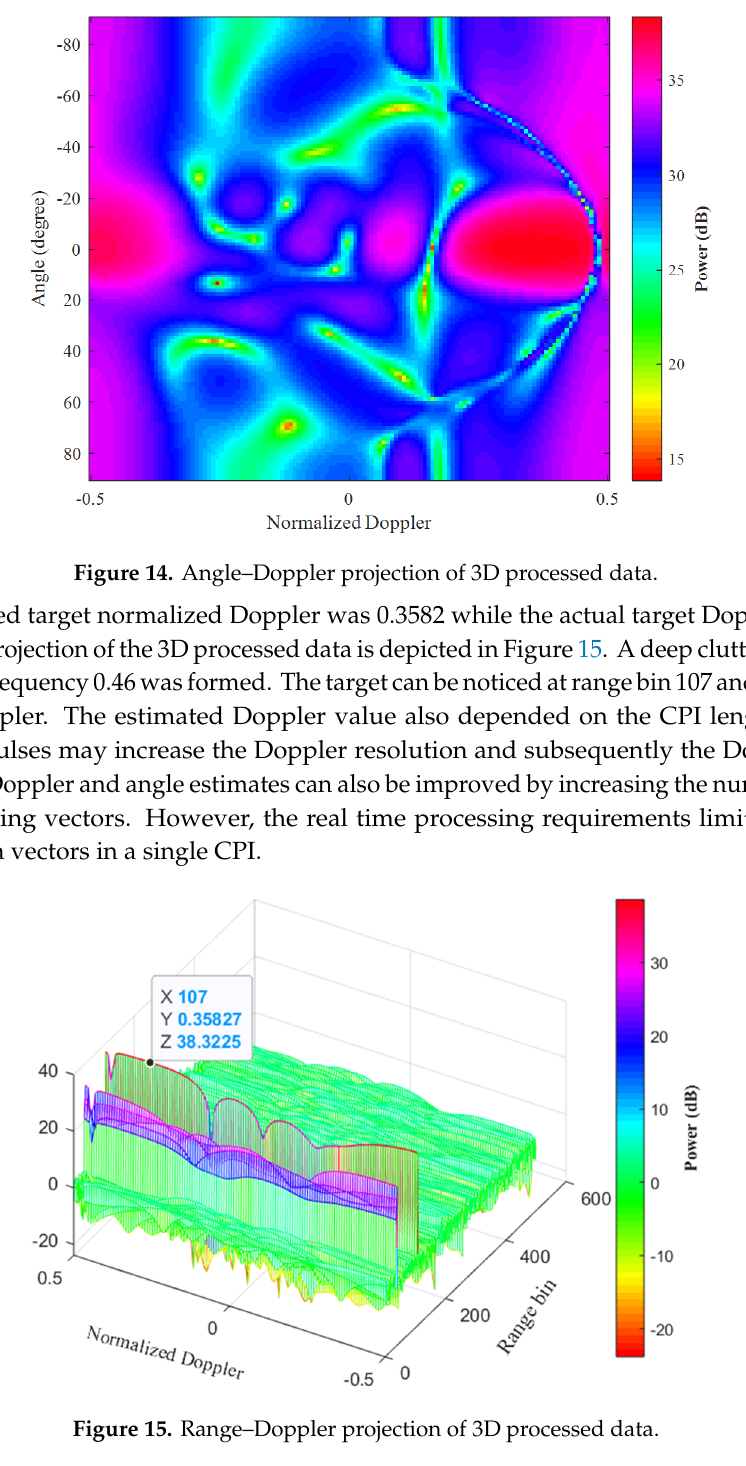
Figure 13. 1D range processed data.